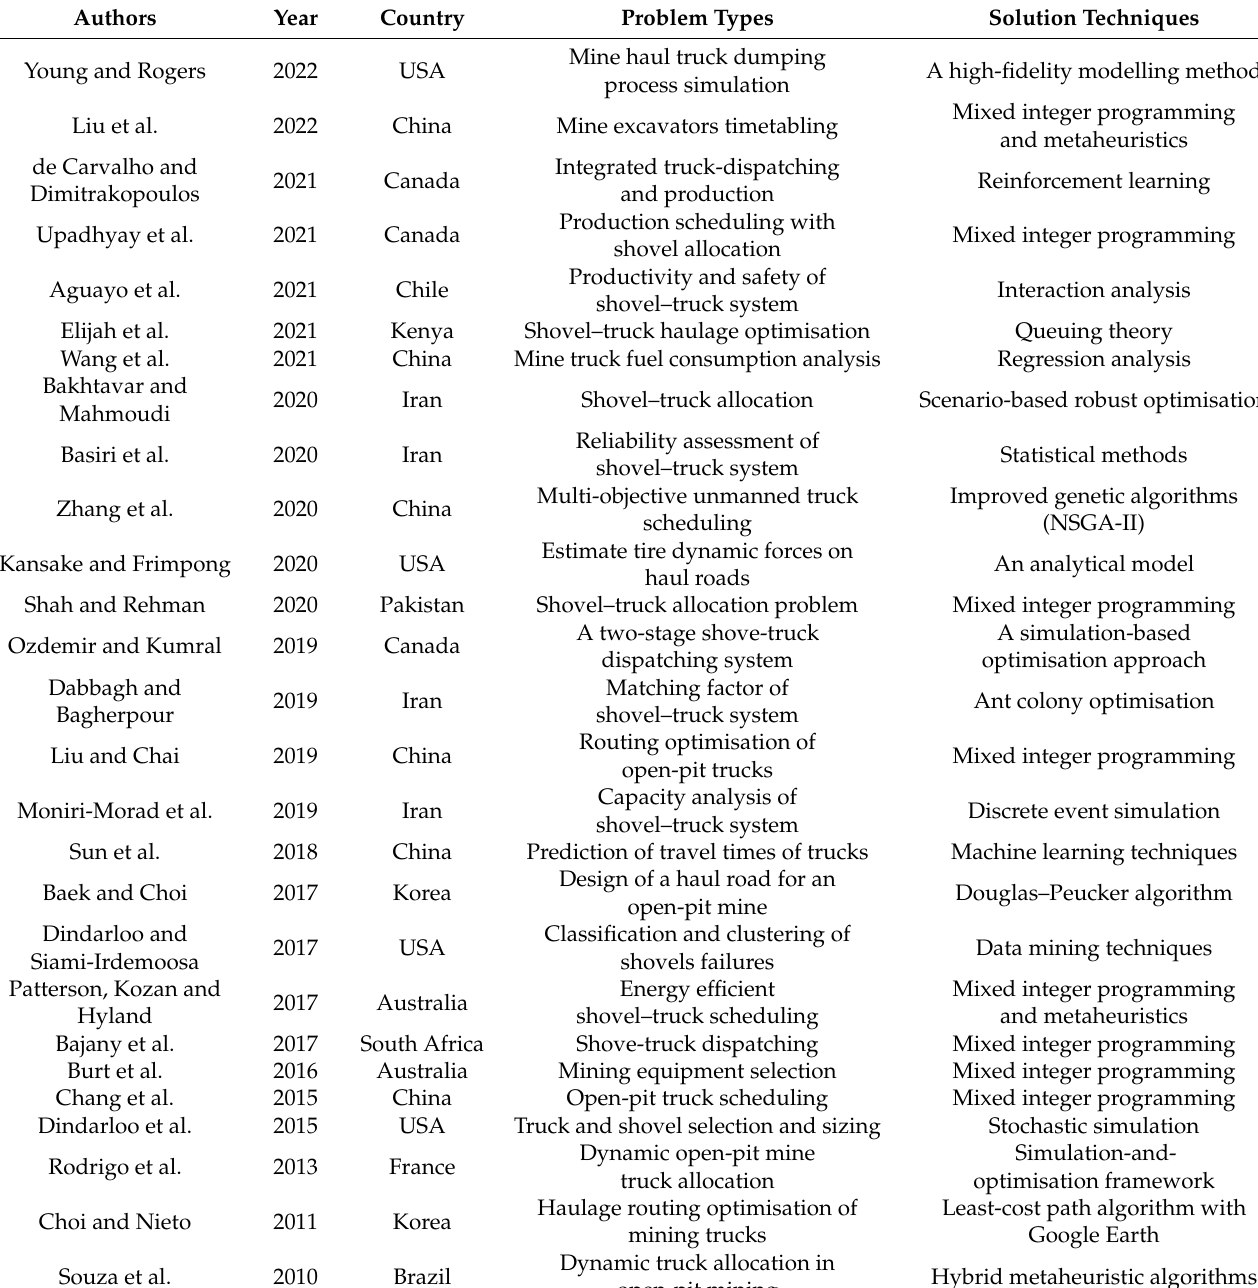
Table 1. Characteristics analysis of publications on the shovel–truck (ST) system